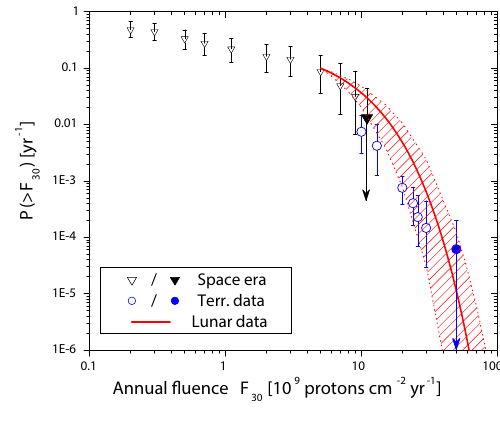
Fig. 26 The record ( black ) of Δ 14 C (IntCal09 Reimer et al. 2009) throughout the Holocene, along with the expected signal ( red ) in the decadal Δ 14 C data, from a scaled 775 AD event (denoted as “E”) Fig. 27 Cumulative probability (with the 90% confidence interval) of occurrence of a SEP event with fluence ( > 30 MeV) exceeding the given value F 30 , as assessed from the data for the space era 1956–2008 ( black triangles ), cosmogenic isotope data ( blue circles ), and cosmogenic data from lunar rocks ( red shaded area ). Modified after Kovaltsov and Usoskin (2014)